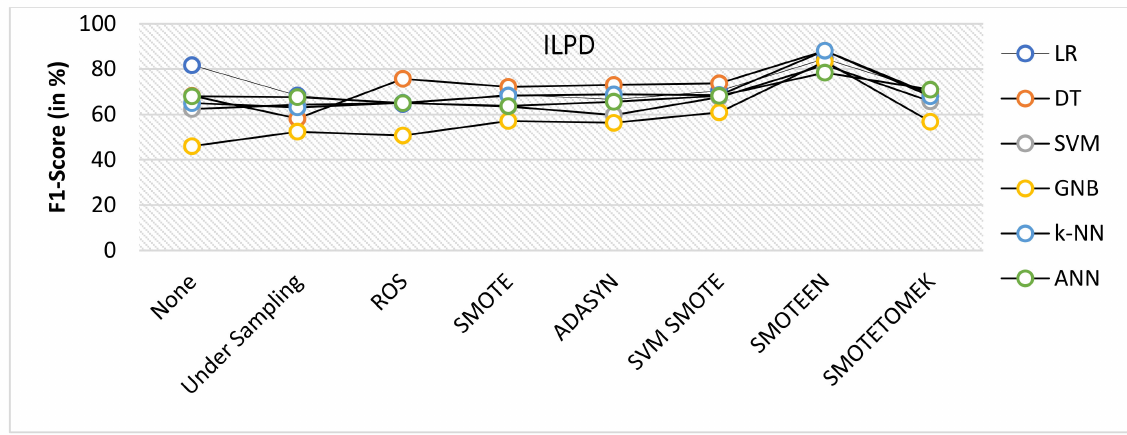
Figure 13. F1 score for ILPD dataset of balancing algorithms over six